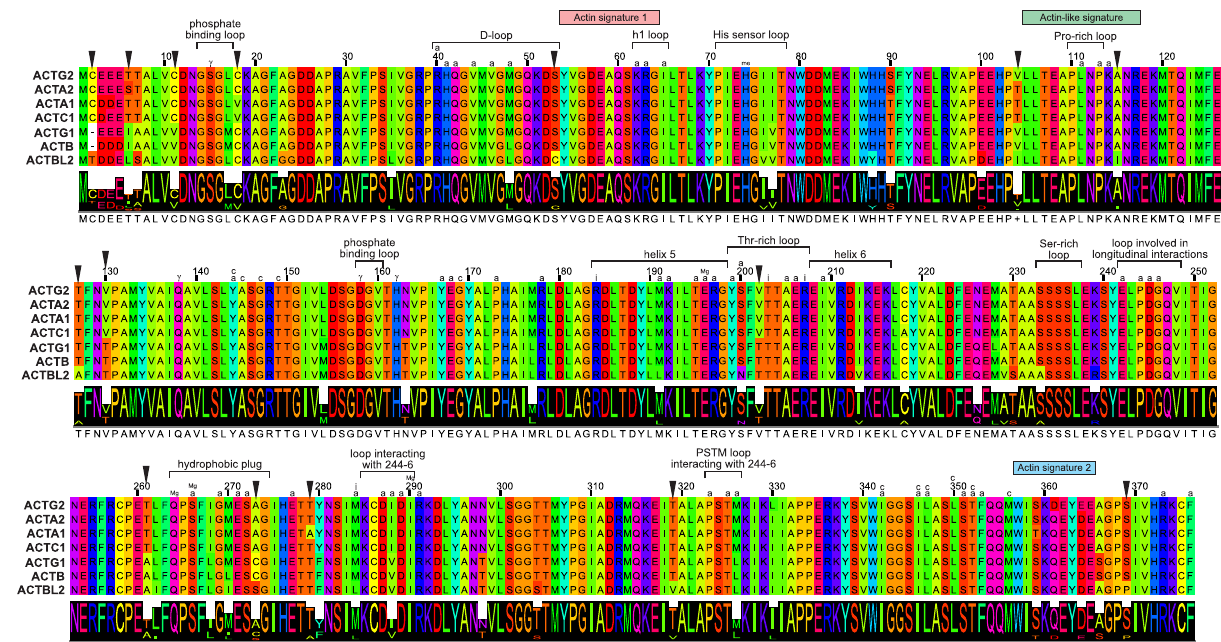
Figure 3. The alignment of the majority-rule consensus sequence for seven actin groups obtained from profile HMMs. Black triangles indicate columns, including non-conserved amino acid substitutions. Residues interacting with other residues of the actin filament were marked by a, and γ phosphate of nucleotide by γ. Residues co-ordinating inorganic phosphate ions were marked by i, and Mg 2+ ions by Mg. Residues involved in the lower cleft were marked by c. Moreover, selected structural features of actins were marked, as well as actin signature 1 (PS00406), actin signature 2 (PS00432), and actin-like signature (PS01132). Annotation of residues was taken from 16,17